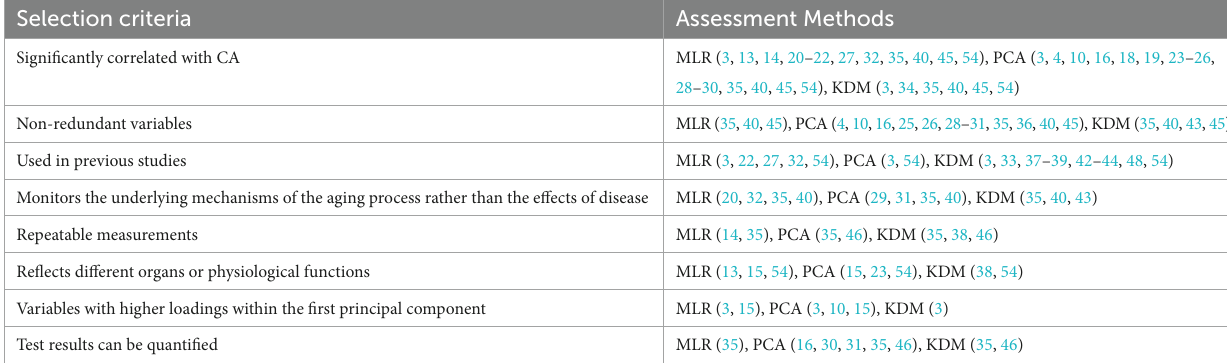
TABLE 2 The selection criteria for aging biomarkers among MLR, PCA, and KDM. Selection criteria Assessment